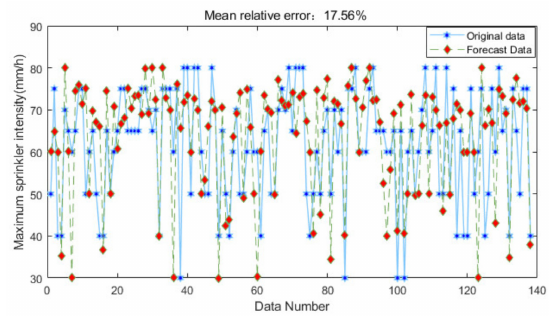
Figure 10. The smoothness parameter of the GRNN is 0.02.